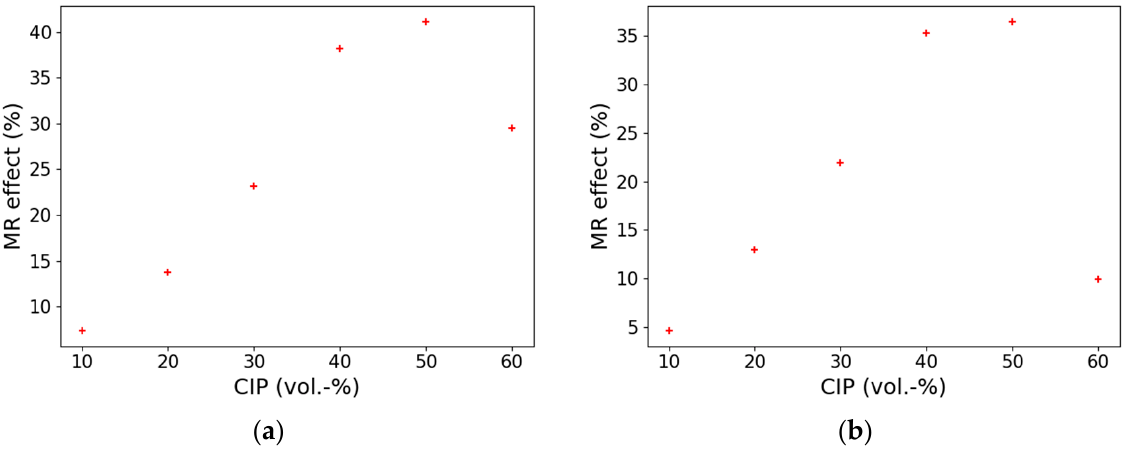
Figure 5. The influence of the CIP content on the MR effect ( a ) for the static test, a strain amplitude of 1% and pre-strain of 1.53% was used; ( b ) for the dynamic test, a strain amplitude of 0.66% was investigated. STL matrix with different concentrations of HS-type CIP; a constant frequency of 10 Hz and field strength of 0.54 T was selected for all tests.